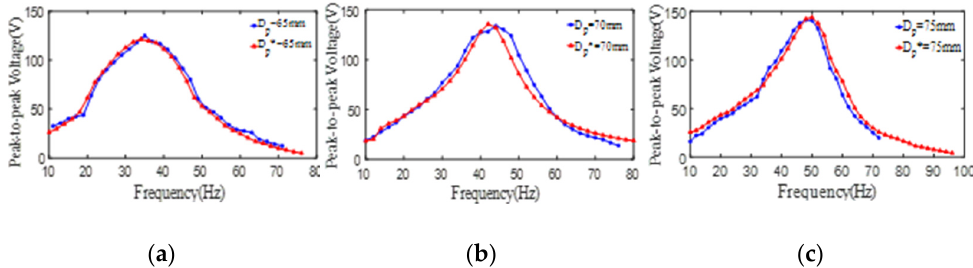
Figure 12. The relationship curves of the peak-to-peak voltage and the excitation frequency of the unimorph PCD from experimental results (blue line) and simulation results (red line). ( a ) peak-to-peak voltage of PCD with D p = 65 mm; ( b ) peak-to-peak voltage of PCD with D p = 70 mm; ( c ) peak-to-peak voltage of PCD with D p = 75 mm.